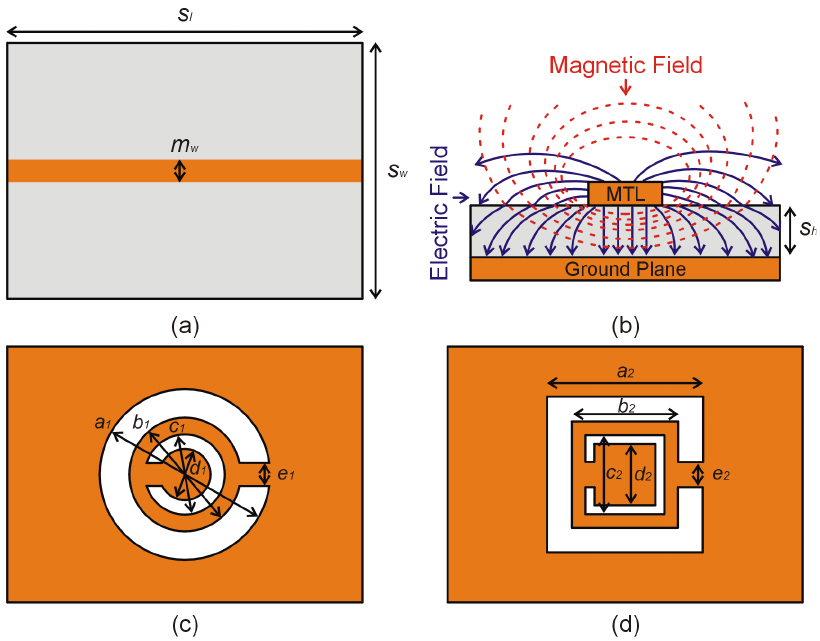
Figure 1. ( a ) Top view of the sensor based on the RO4003C substrate and microstrip transmission line (MTL), ( b ) Electromagnetic fields created by the MTL, ( c ) Geometry of the optimized CC ‐ SRR, and ( d ) Geometry of the optimized SC ‐ SRR.